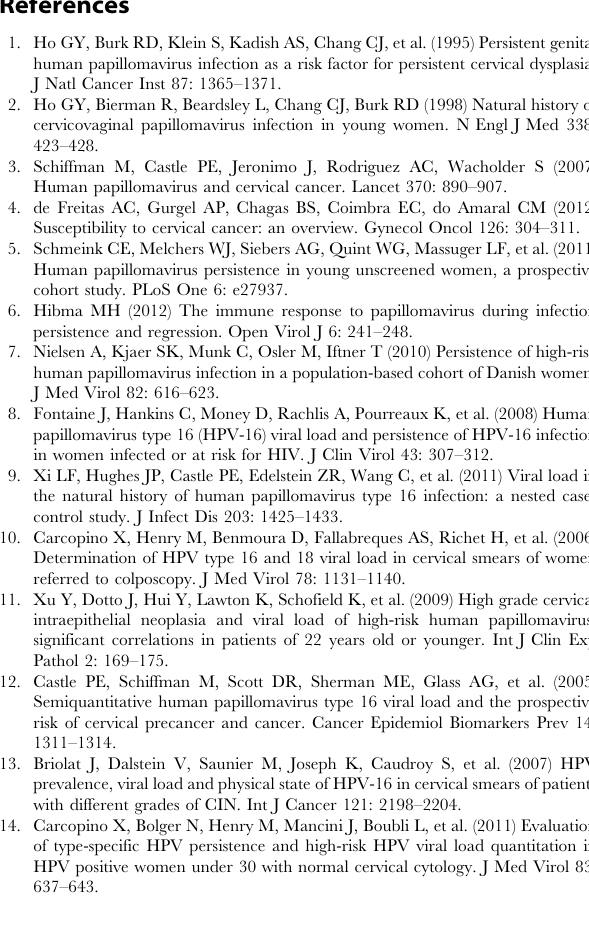
Table S3 Interaction between high HR-HPV load and alcohol consumption on the risk of 2 year-HR-HPV persistence. { N w/wo persistence, the number of